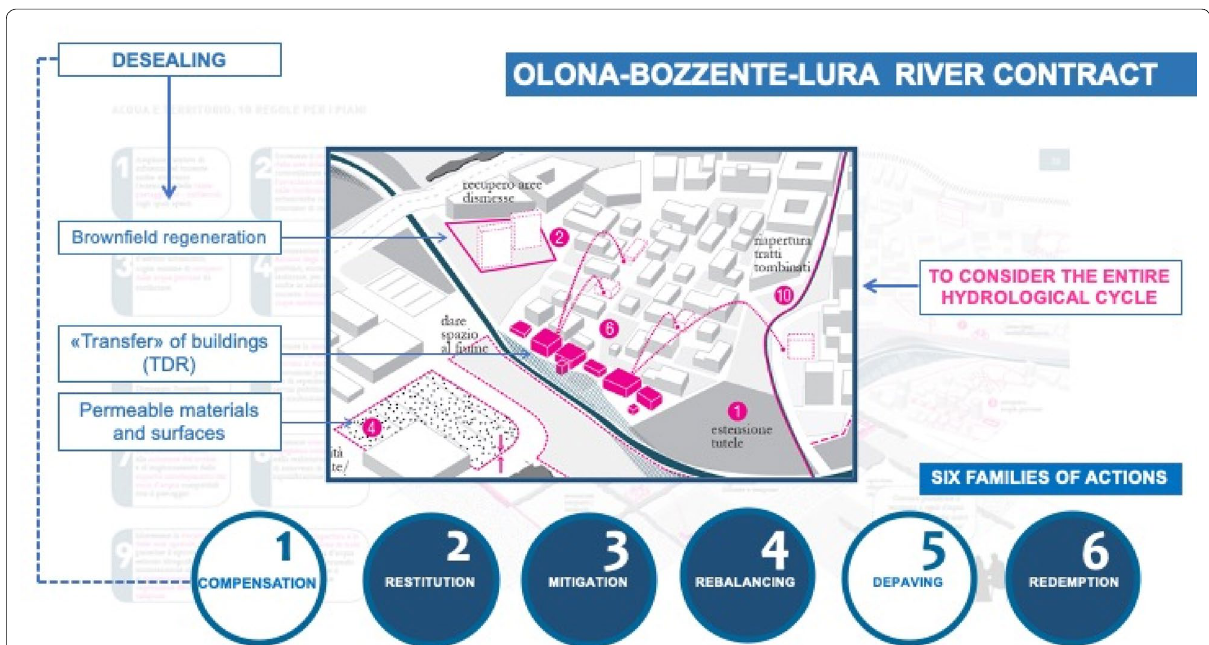
Fig. 4 Example of planning tool indications: recovery of the filtering capacity of the floors; re-naturalization of watercourses; demolition or transfer of buildings (Source: Olona-Bozzente-Lura River Contract/elaboration of the